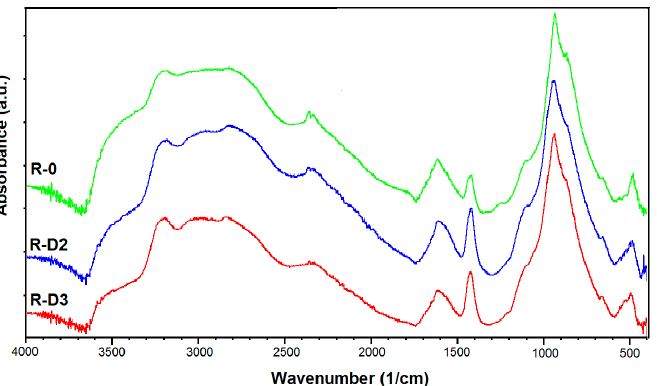
Figure 9. FTIR spectra for selected charred coatings with PER-CNTs solid dispersions.